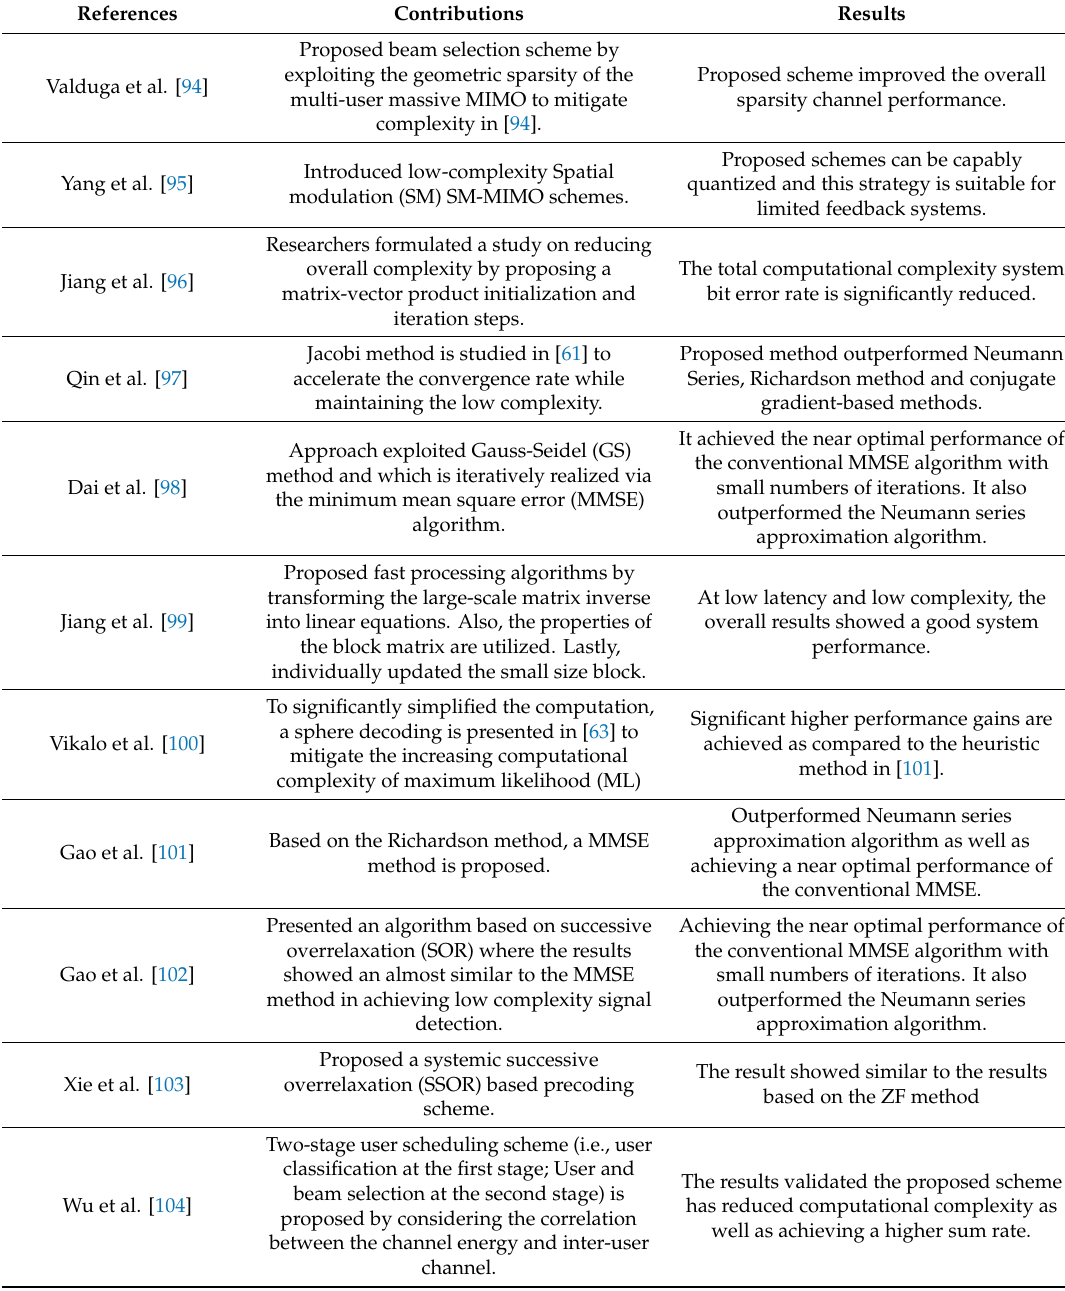
Table 4. Summary of previous works on the low complexity